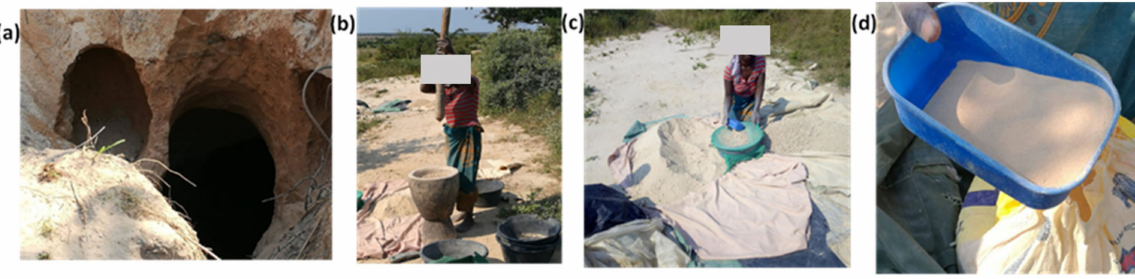
Figure 2. Extraction and preparation of geophagic materials: ( a ) open pits; ( b ) crushing; ( c ) sieving; and ( d ) final